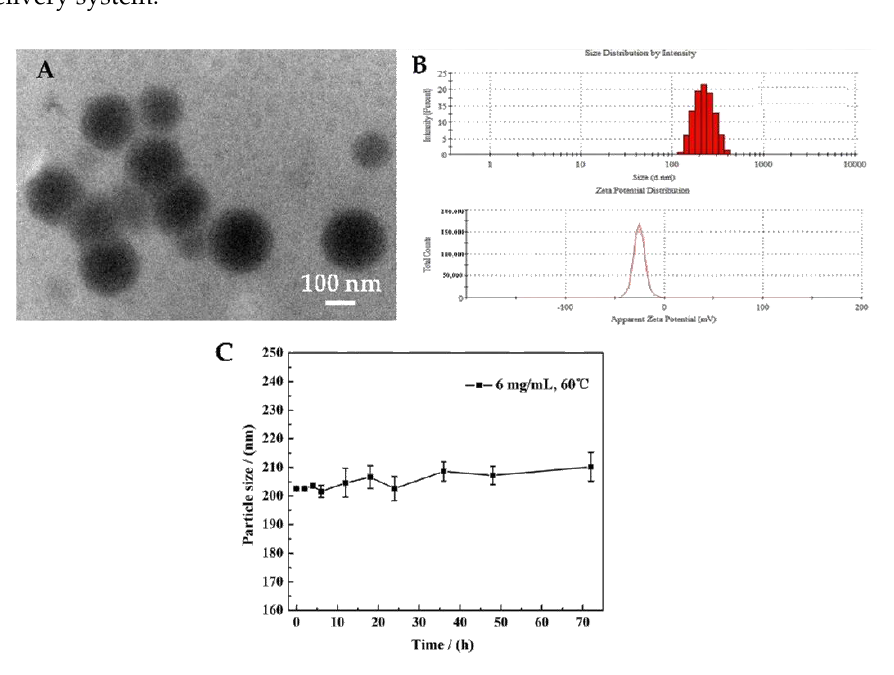
Figure 2. ( A ) TEM image (×100,000), ( B ) the particle size and ξ-potential, ( C ) the stability of prepared TP 5 -NPs. TP 5 -NPs had a nearly spherical shape and uniform size with a diameter of ~170 nm by TEM image. The mean particle size of TP 5 -NPs was 205.4 nm and ξ potential was −23.2 mV by